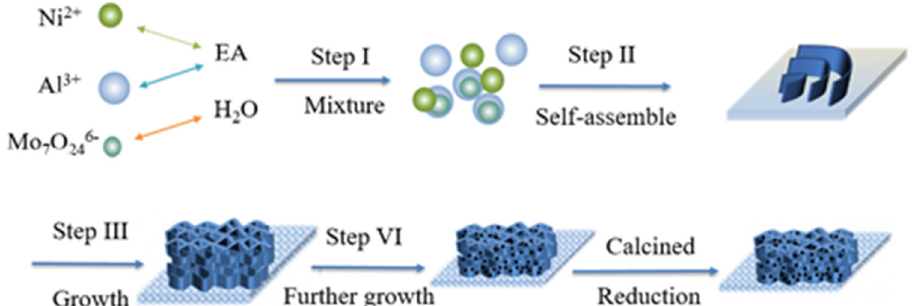
Figure 1. Schematic illustrating for the preparation of Ni 10 Mo x Al